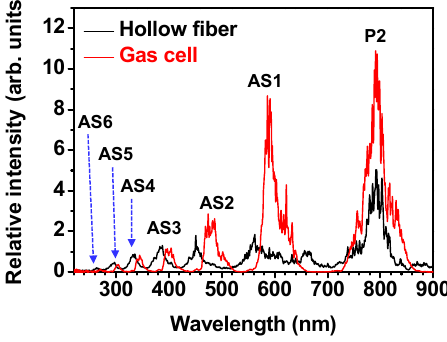
Figure 3. Spectra of output beams from the hollow fiber (black solid line) and the gas cell (red solid line) at a pressure of 2 atm. The spectra for P1 are not shown in the figure.